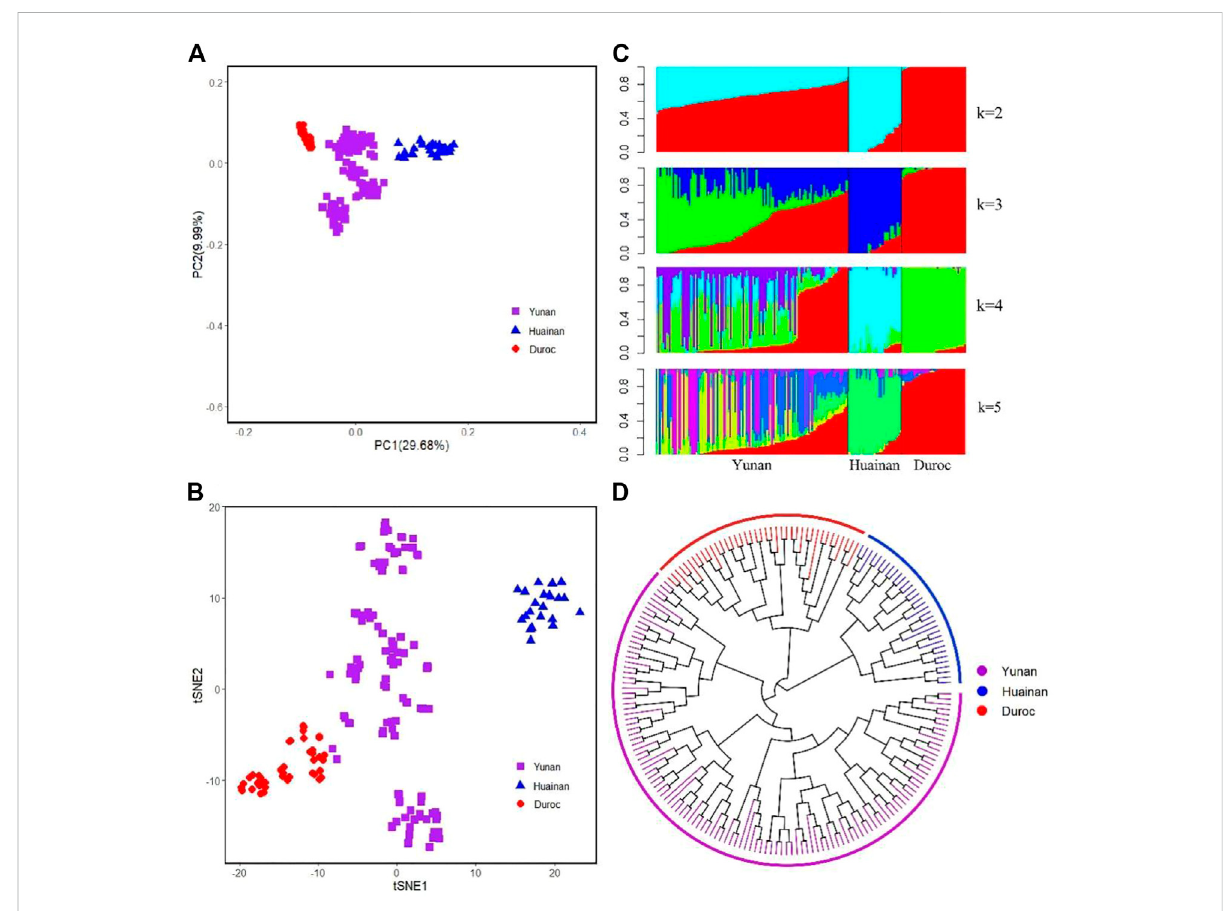
FIGURE 4 Population structure analyses for all pig individuals. (A) First and second principal components from a principal component analysis of all populations. (B) t-SNE plot for all breeds. (C) Population structure plots for all pig populations at K = 2, 3, 4, and 5. (D) Neighbor-joining tree for all individual